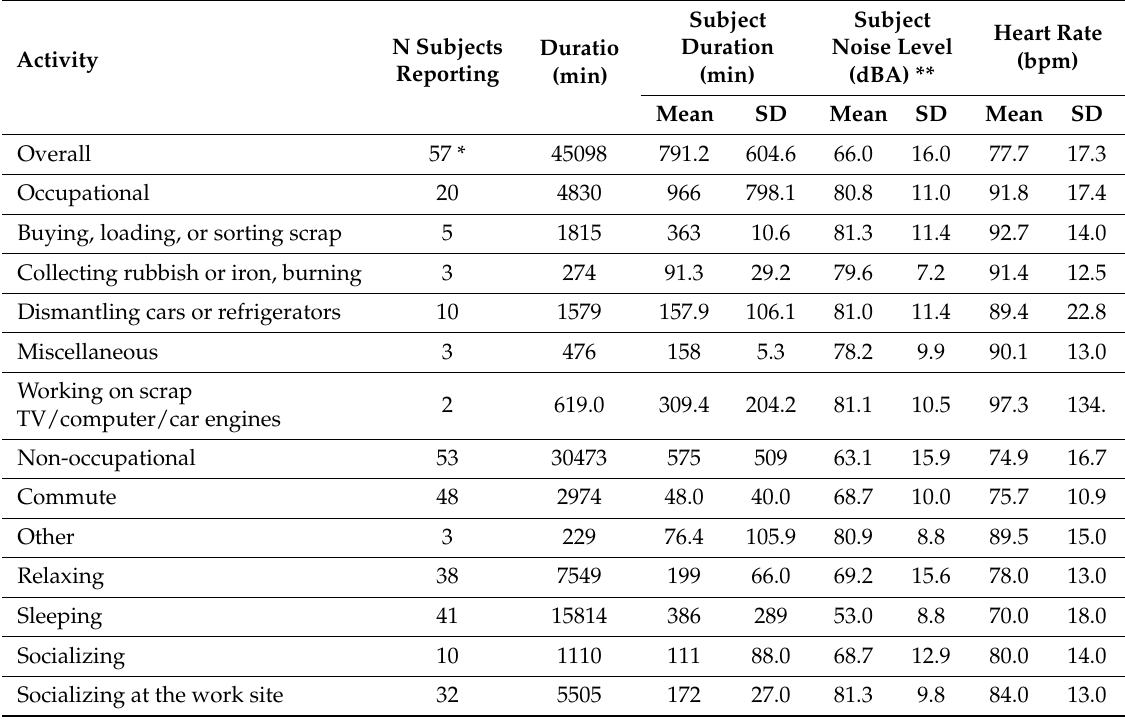
Noise exposures and matched heart rates related to work and non-work activities ( N = 56